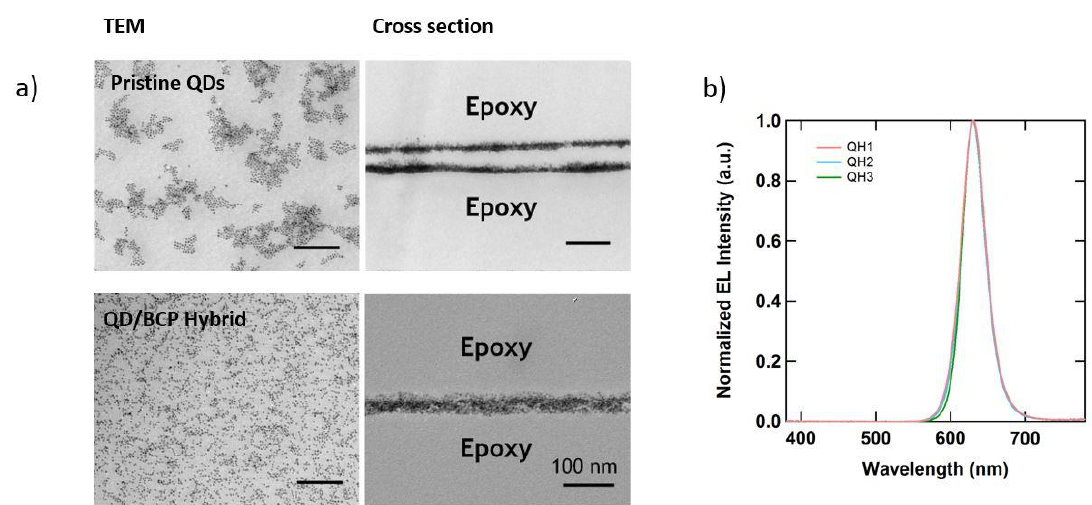
Figure 11. CdSe QDs as light emitting material in a matrix of semiconducting polymer for the preparation of an QLED; ( a ) dispersibility as viewed from the top and the side [135] (note the homogeneous dispersion of the polymer coated hybrids); ( b ) electroluminescence from 3 hybrid systems (QH1 to QH3, see ref. for assignment); they are identical to the electroluminescence of the pure QDs; reproduced with permission of [135], published by Wiley-VCH, 2009.